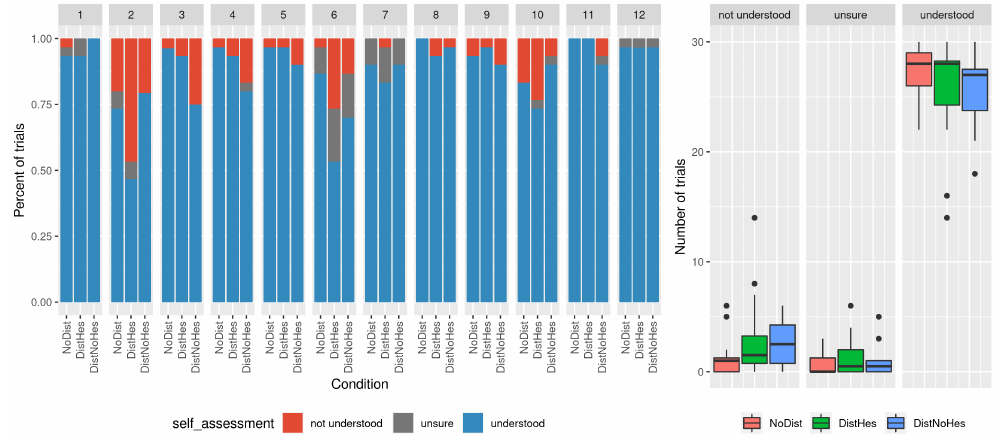
Figure 6. Self-assessment of understanding the instruction for each participant ( left ) and over all participants ( right ).